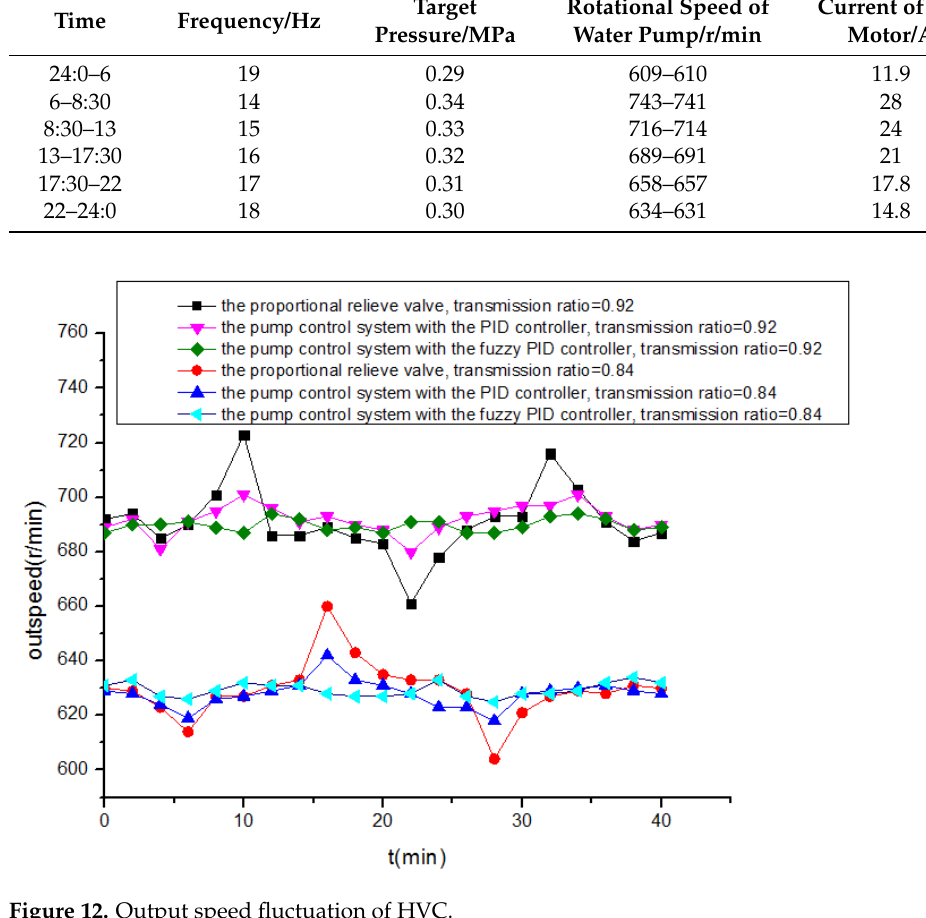
Figure 12. Output speed fluctuation of HVC.